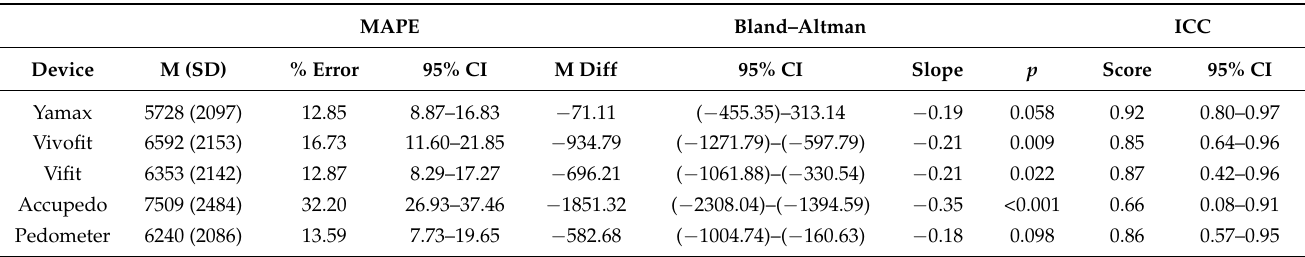
Table 3. Step count MAPE, Bland–Altman and ICC results for the field